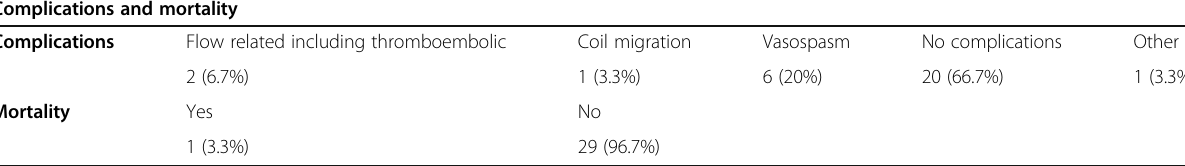
Table 5 Complications and mortality Complications and mortality